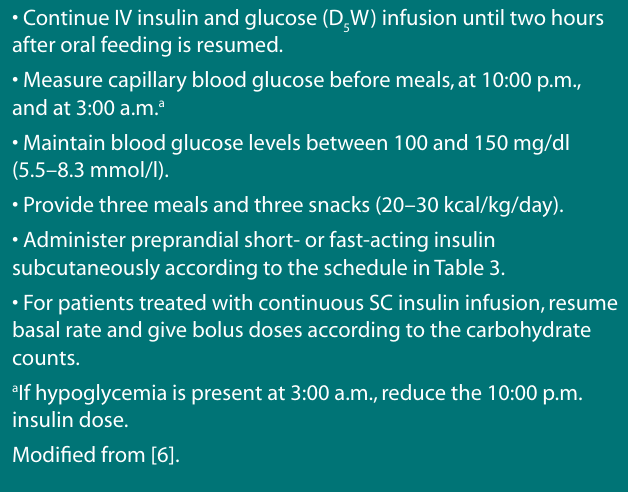
Table 3. Administering Insulin after Surgery Blood Glucose Short- or Fast-Acting Insulin (Units) Breakfast Lunch